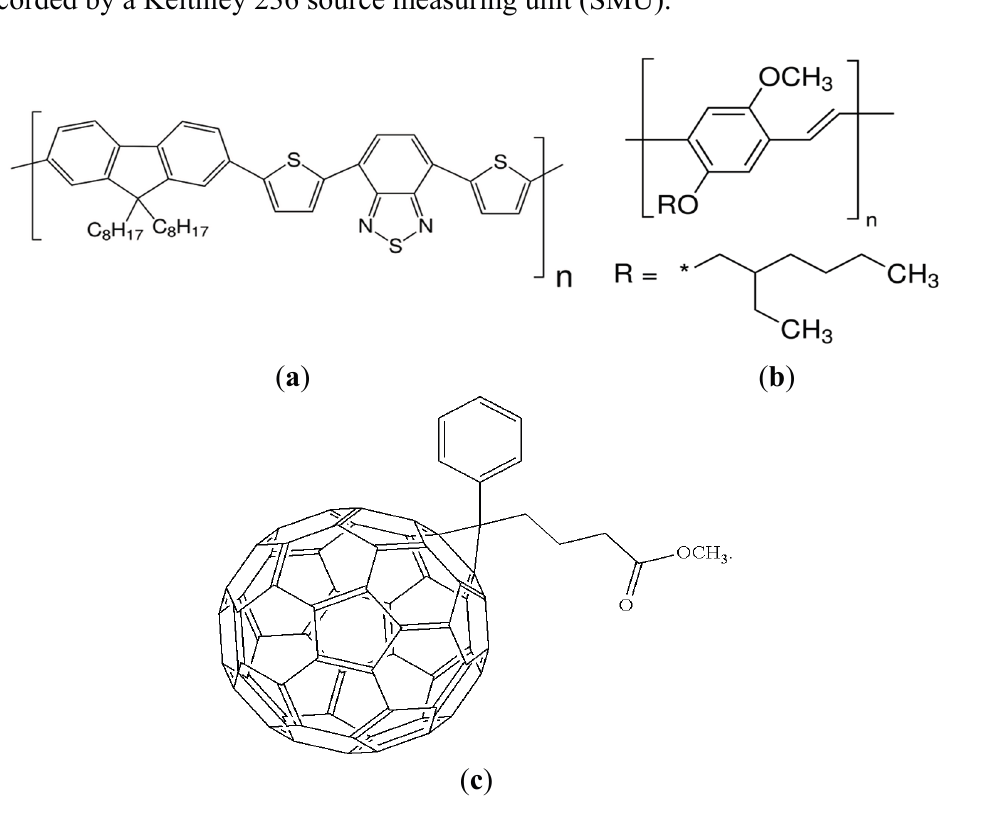
Figure 1. The molecular structure of ( a ) PFO-DBT ( b ) MEH-PPV and ( c ) PC 71